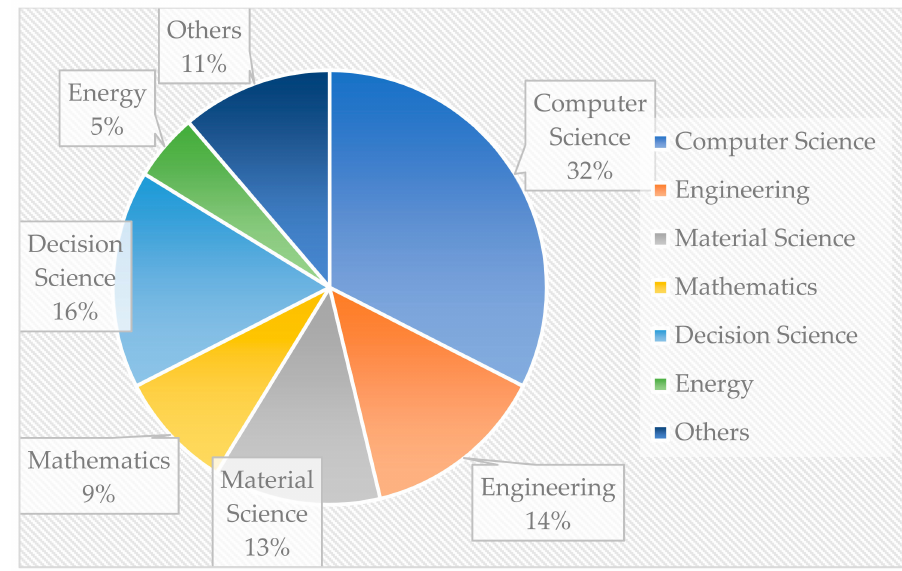
Figure 5. Distribution of the studies in terms of subject